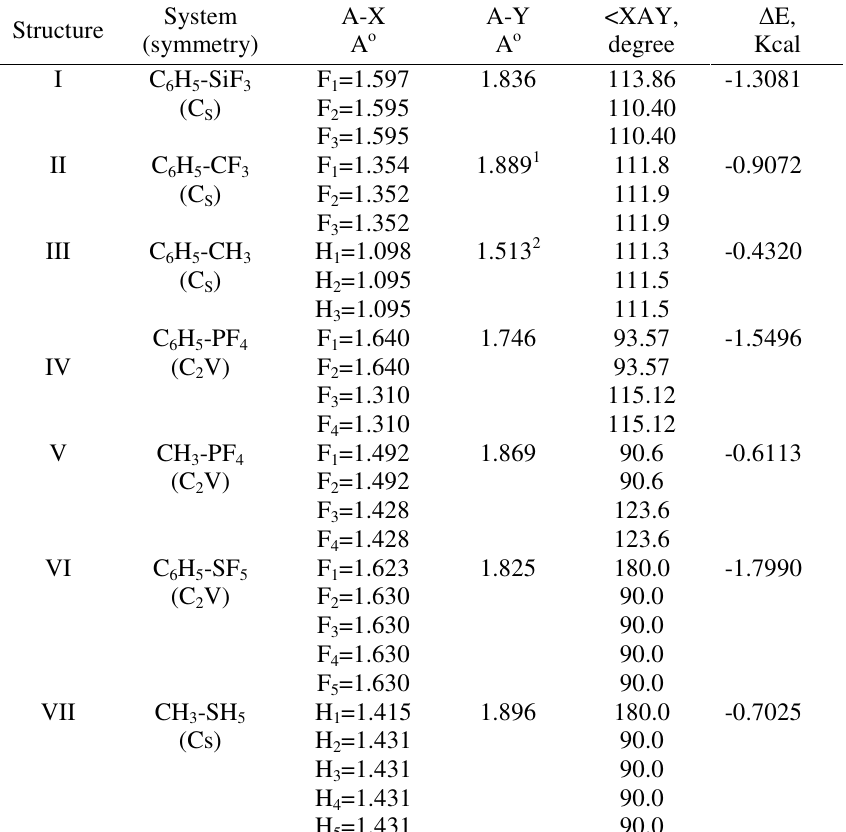
Table 1. The geometrical parameters and stabilization energies of various systems obtained by DFT 6-31 G* MO